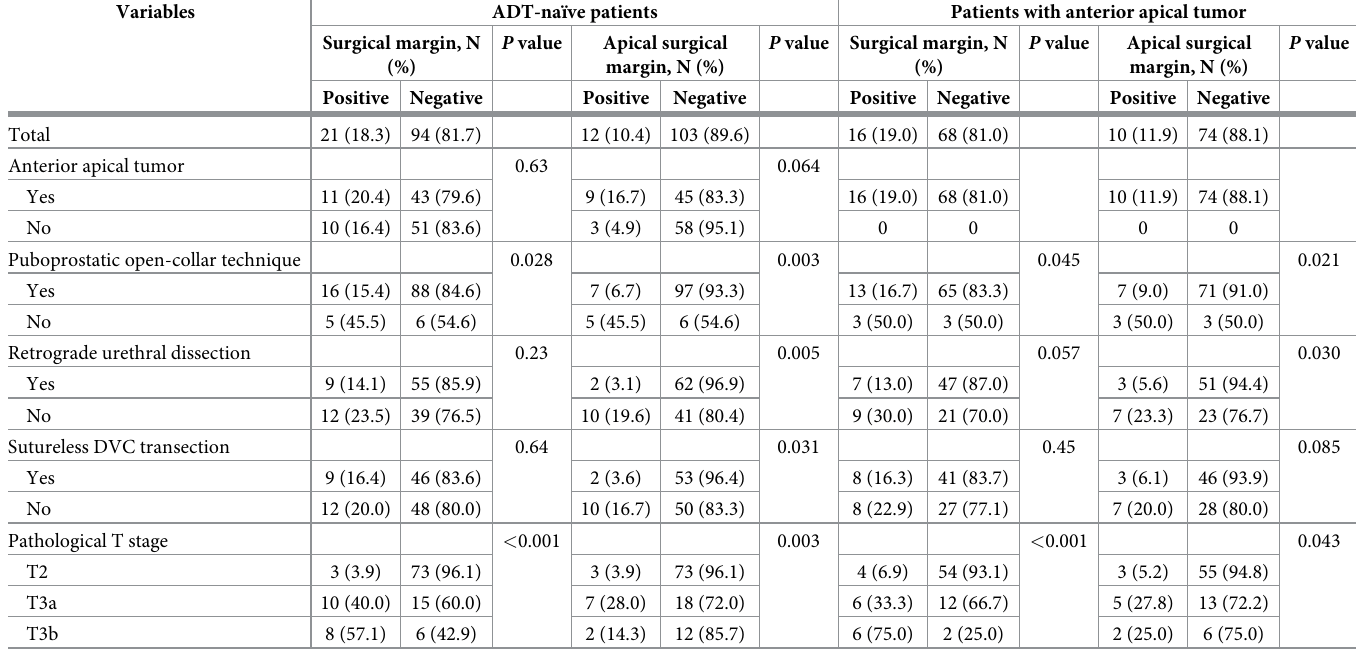
Table 3. Associations of clinicopathologic variables with surgical margin status in subsets of 115 ADT-na ï ve patients and 84 patients with anterior apical tumor on mpMRI. Variables ADT-na ï ve